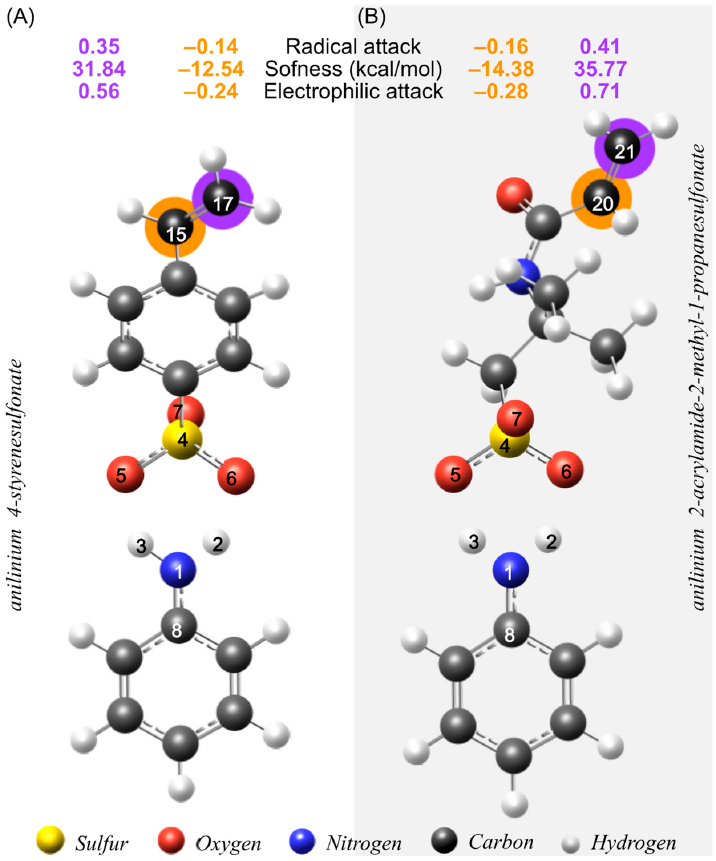
Figure 3. Reactive sites for free radical attacks. ( A ) ani-SS and ( B ) ani-AMPS.